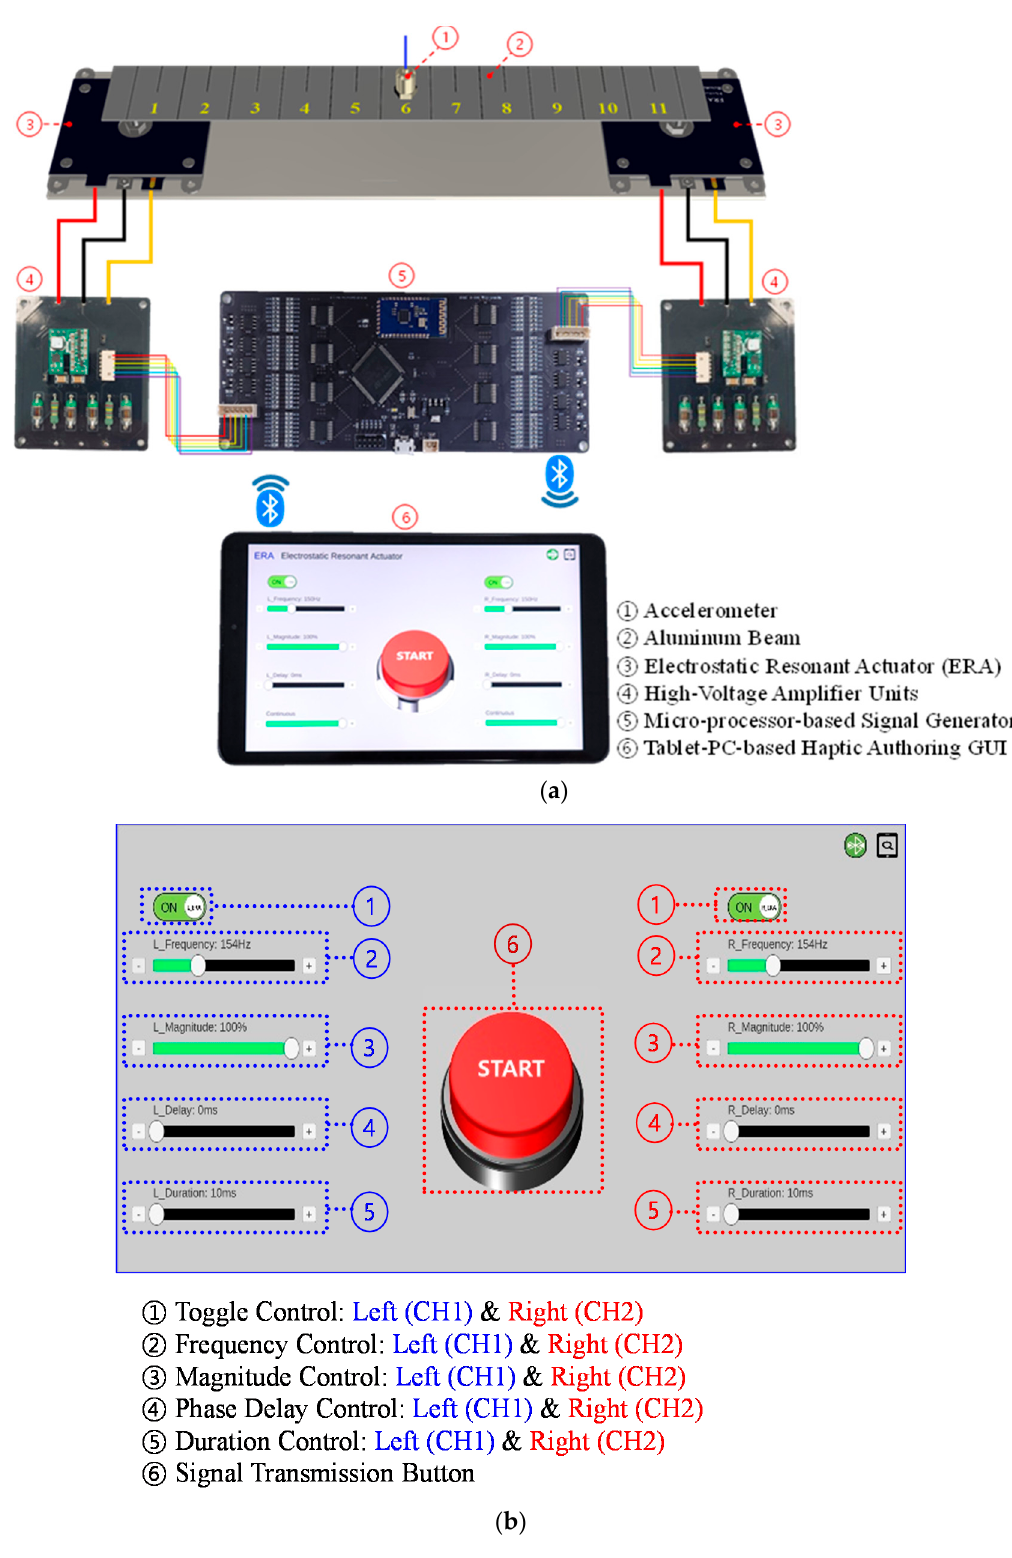
Figure 3. Experimental setup showing: ( a ) Actuator-beam system and high-voltage controller; ( b ) haptic authoring GUI used to control actuator frequency, magnitude, phase delay, and duration.